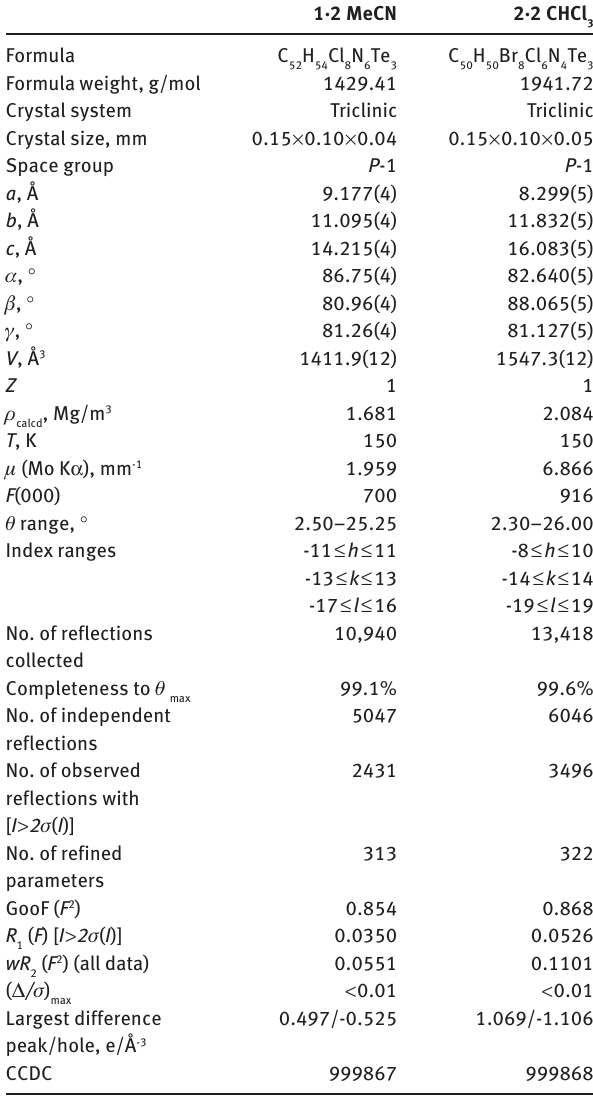
Table 1 Crystal data and structure refinement of compounds 1 and 2